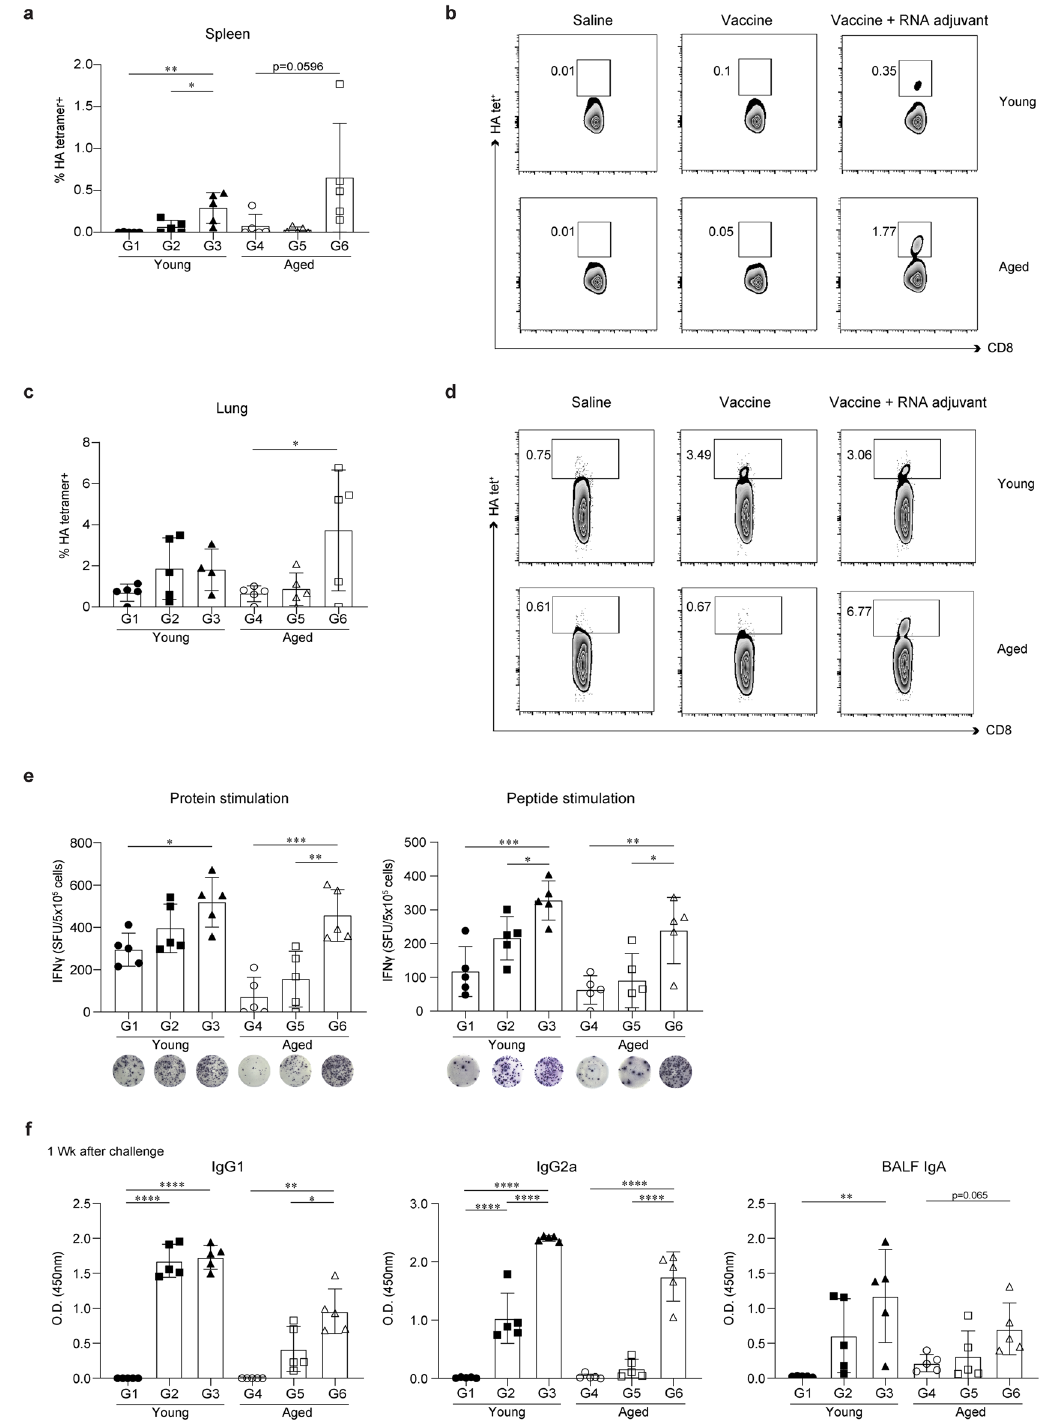
Figure 3. Inactivated influenza vaccine (IIV) formulated with ssRNA increases the generation of influenza HA-specific T cells and humoral response against influenza virus. Splenocytes and lung lymphocytes were harvested 1 week after challenge. For conducting the ELISPOT assay, cells were stimulated for 2 days with or without IIV or influenza HA-specific T cell epitope peptide. Detailed peptide sequences are listed in the “Materials and methods”. For estimation of levels of IgG1, IgG2a, and IgA, sera and BALF were collected 1 week after challenge. The experimental groups are described in Fig. 1a. Data are represented as mean ± SD and were statistically analyzed using the one-way ANOVA. The significance of differences between groups are indicated by bars and symbols as follows: *p < 0.05; **p < 0.01; ***p < 0.001; ****p < 0.0001. Percentages of HA-specific tetramer in the spleen ( a , b ) (n = 5 mice for G1 to G6) and lungs ( c , d ) (n = 4 mice for G3 and n = 5 mice for G1, G2, G4, G5, and G6) measured by FACS. ( e ) Spots of influenza HA-specific IFN-γ-producing cells in splenocytes measured using ELISPOT. n = 5 mice for G1–G6. ( f ) IIV-specific IgG1, IgG2a, and BALF IgA levels measured using ELISA 1 week after the challenge. n = 5 mice for